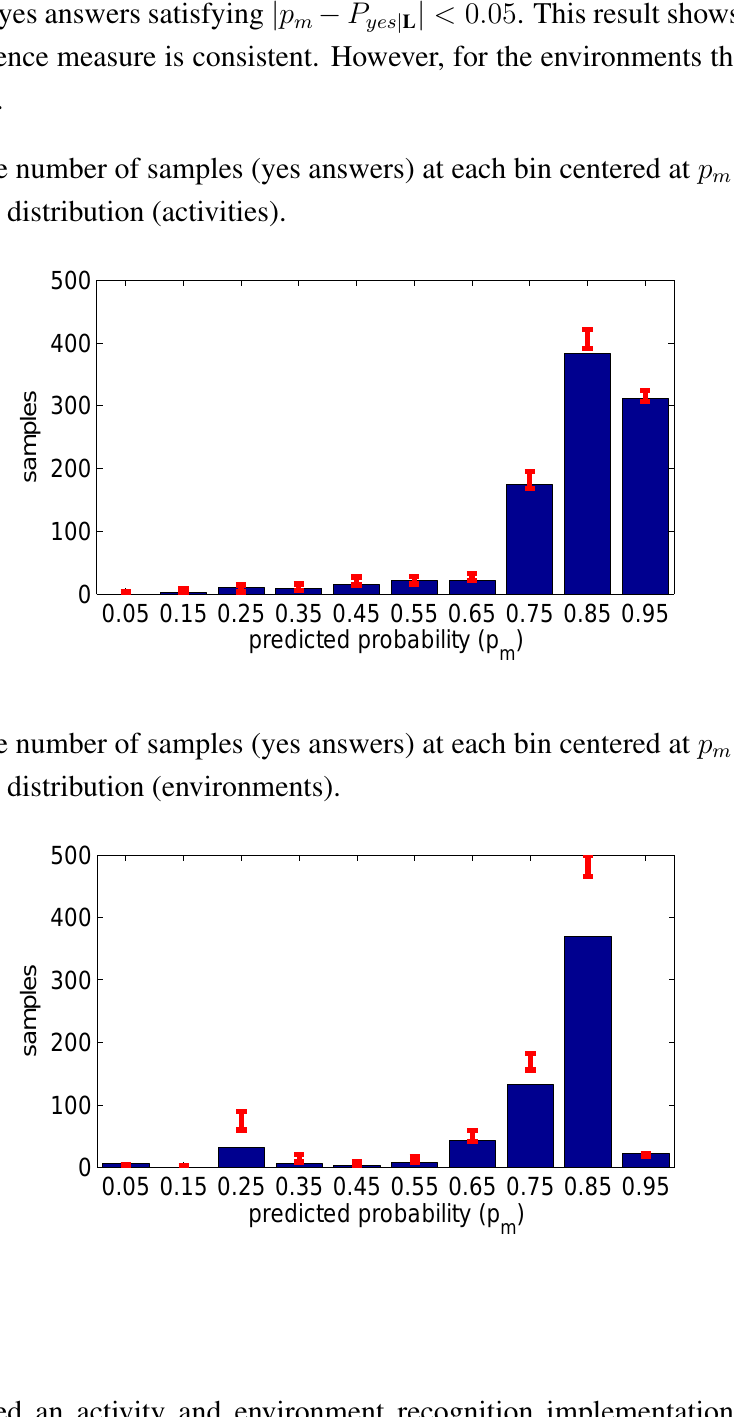
and 95% limits m